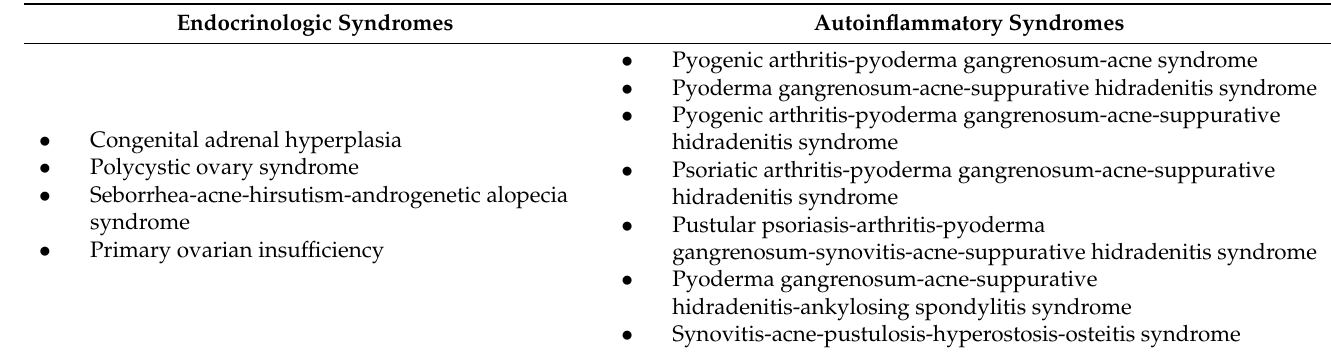
Table 1. Syndromal acne.